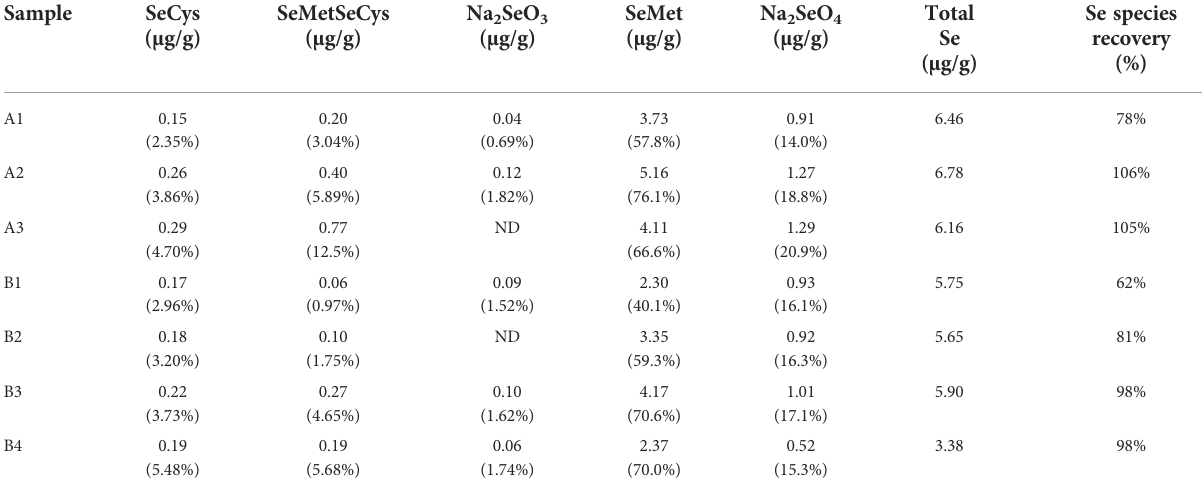
TABLE 3 Selenium species concentrations and percentage (given in brackets) of Se species of total µg/g Se in seeds of pea grown with the foliar treatment of 100 g of Se/ha in the form of selenate.